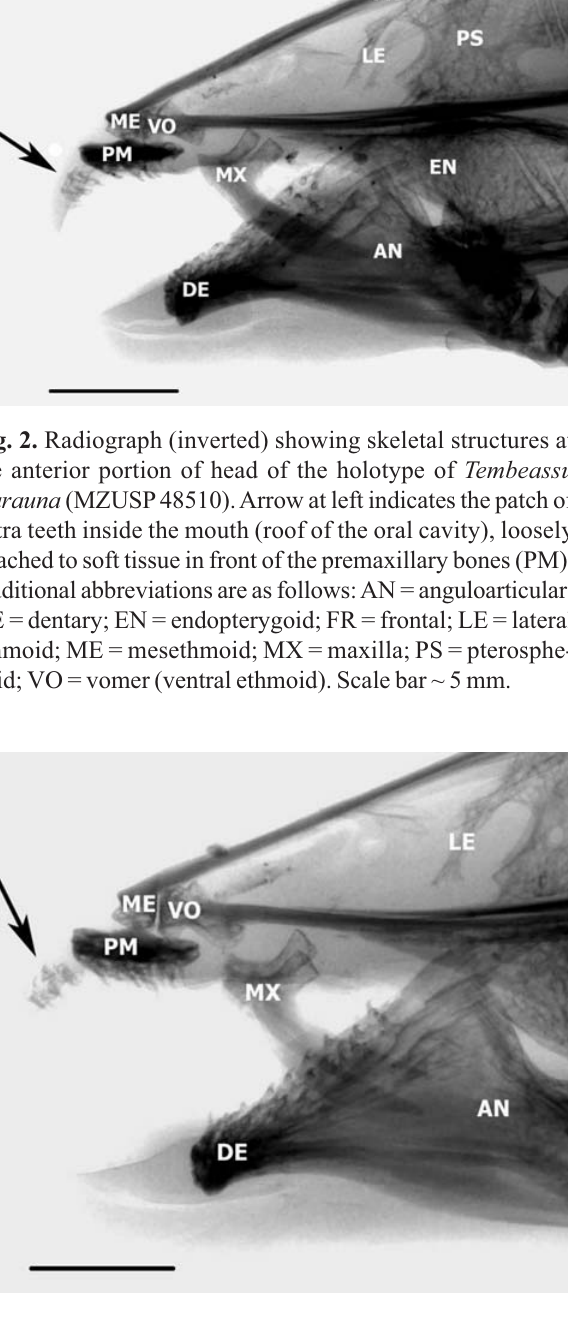
Fig. 3. Radiograph (inverted) showing the left side of the anterior region of head of the male paratype of Tembeassu marauna (MZUSP 23090), also exhibiting the conspicuous forward extension of the fleshy (“boneless”) portions of the upper and lower jaws, in front of the premaxillary (PM) and dentary bones (DE), respectively. Additional abbreviations as in Figure 2. Arrow at left indicates the patch of extra teeth loosely attached to soft tissue at the roof of oral cavity, in front of the premaxillary bones, at the anteriorly extended portion of the upper jaw. Scale bar ~ 5